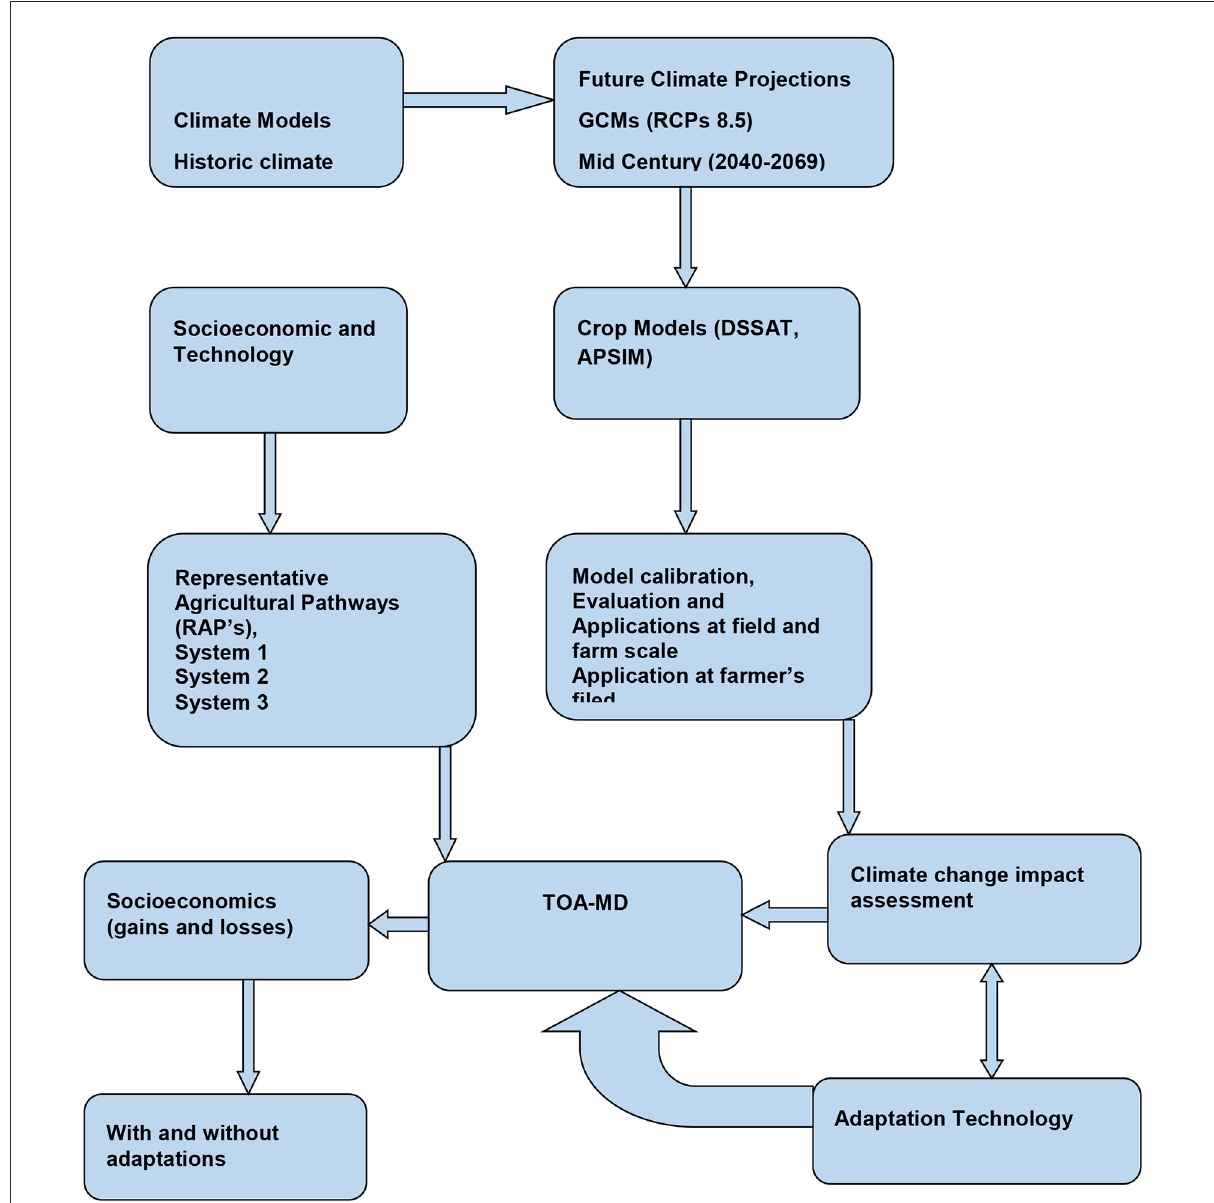
FIGURE6 Schematic illustration showing connections between the different models (climate, crop, and economic) and the points of contact between them in terms of input-output and climate analysis.